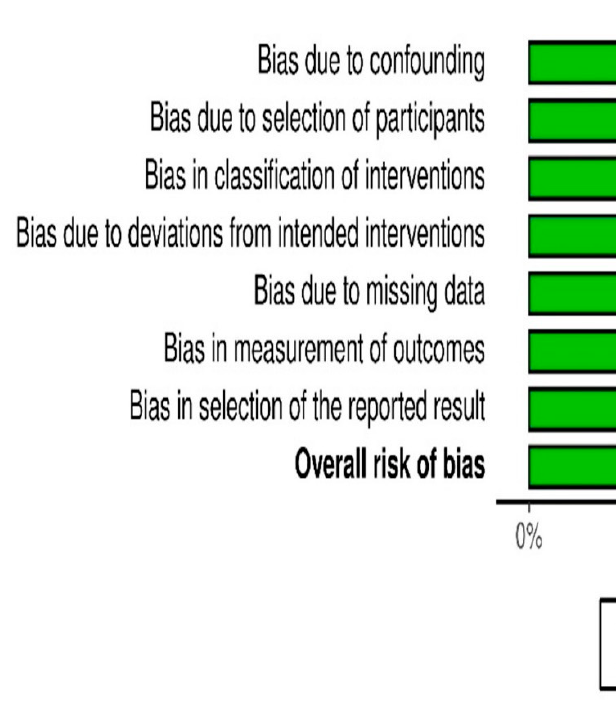
Figure 2. Risk of bias among the selected studies.